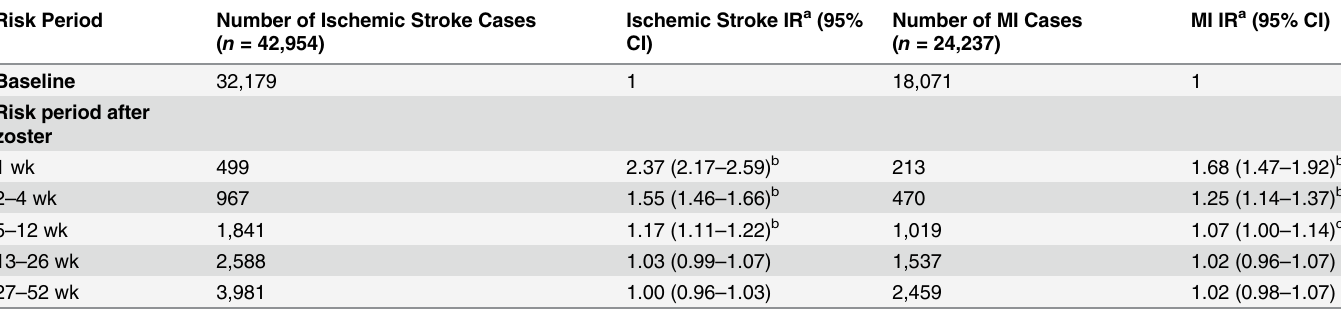
Table 2. Primary analysis: age-adjusted incidence ratios for ischemic stroke and myocardial infarction in risk periods after zoster diagnosis. Risk Period